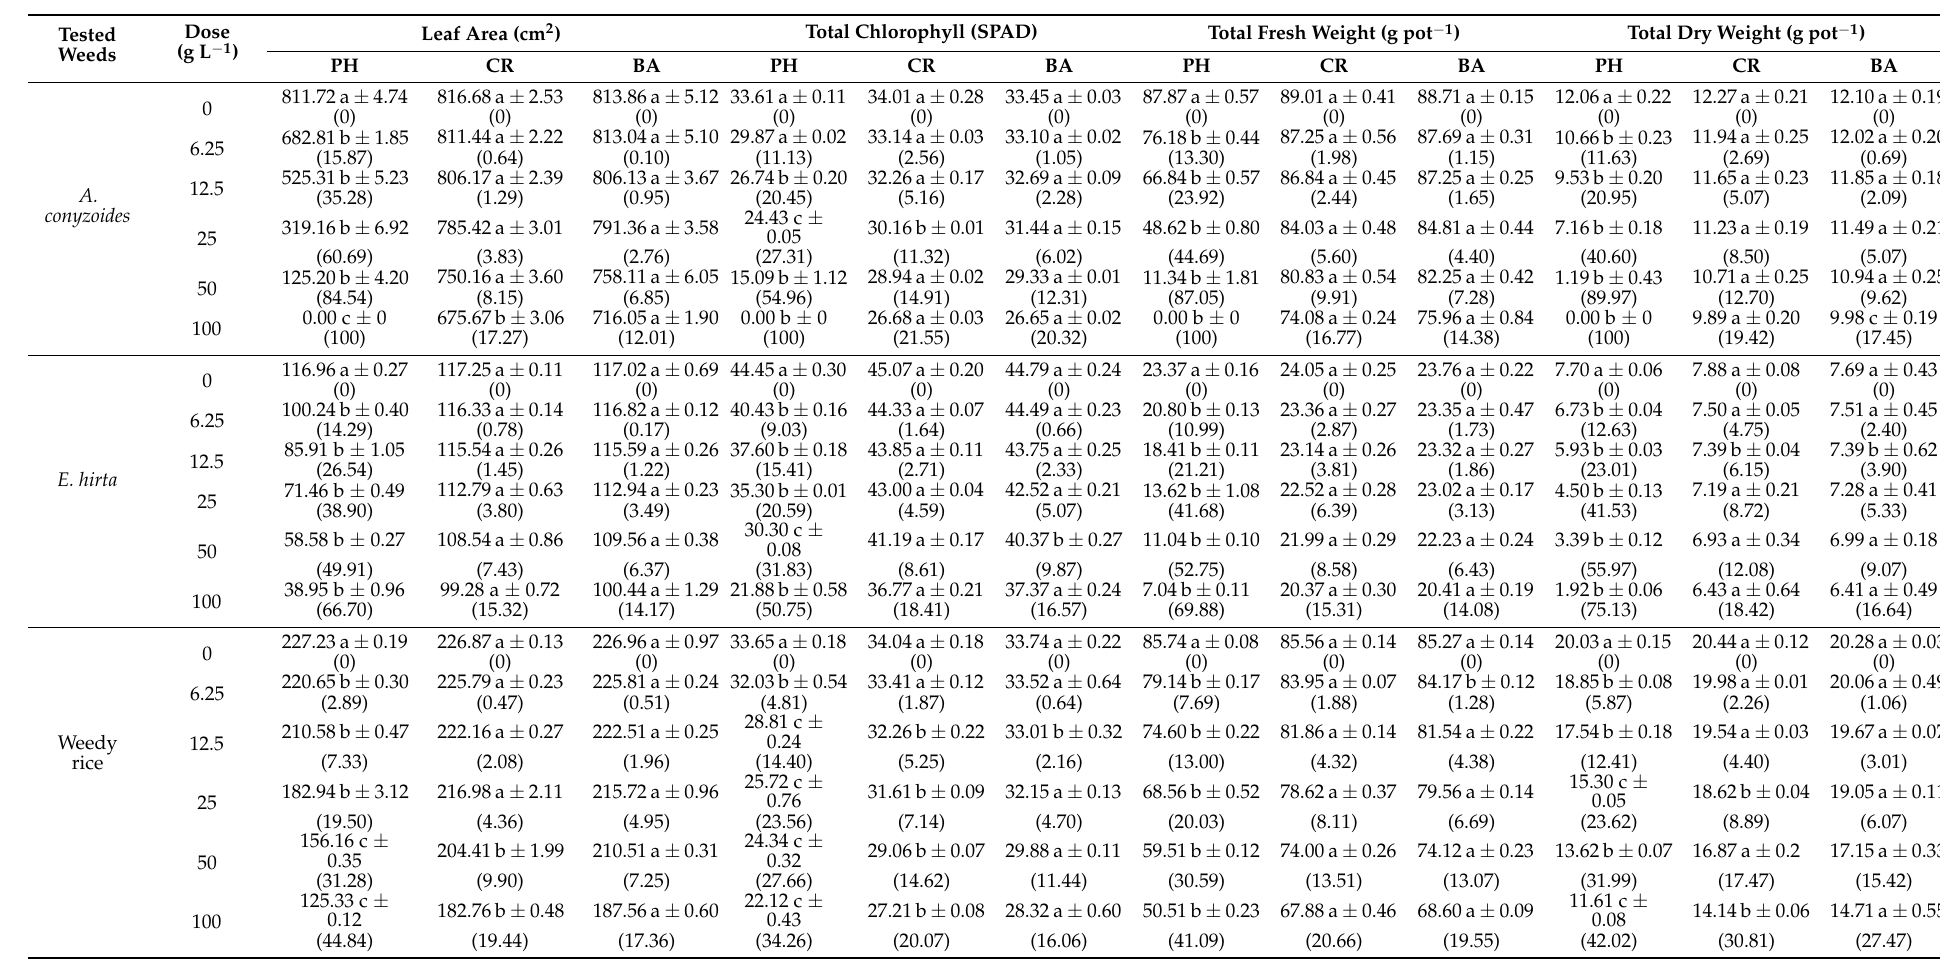
Table 5. Effect of methanol extract of P. hysterophorus , C. rutidosperma , and B. alata on leaf area (cm 2 ), total chlorophyll (SPAD), total fresh weight (g pot − 1 ), and total dry weight (g pot − 1 ) of A. conyzoides , E. hirta , weedy rice, and E. colona